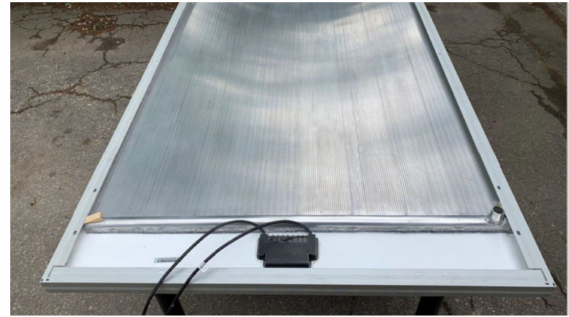
Figure 5. Fabricated microchannel PVT collector.